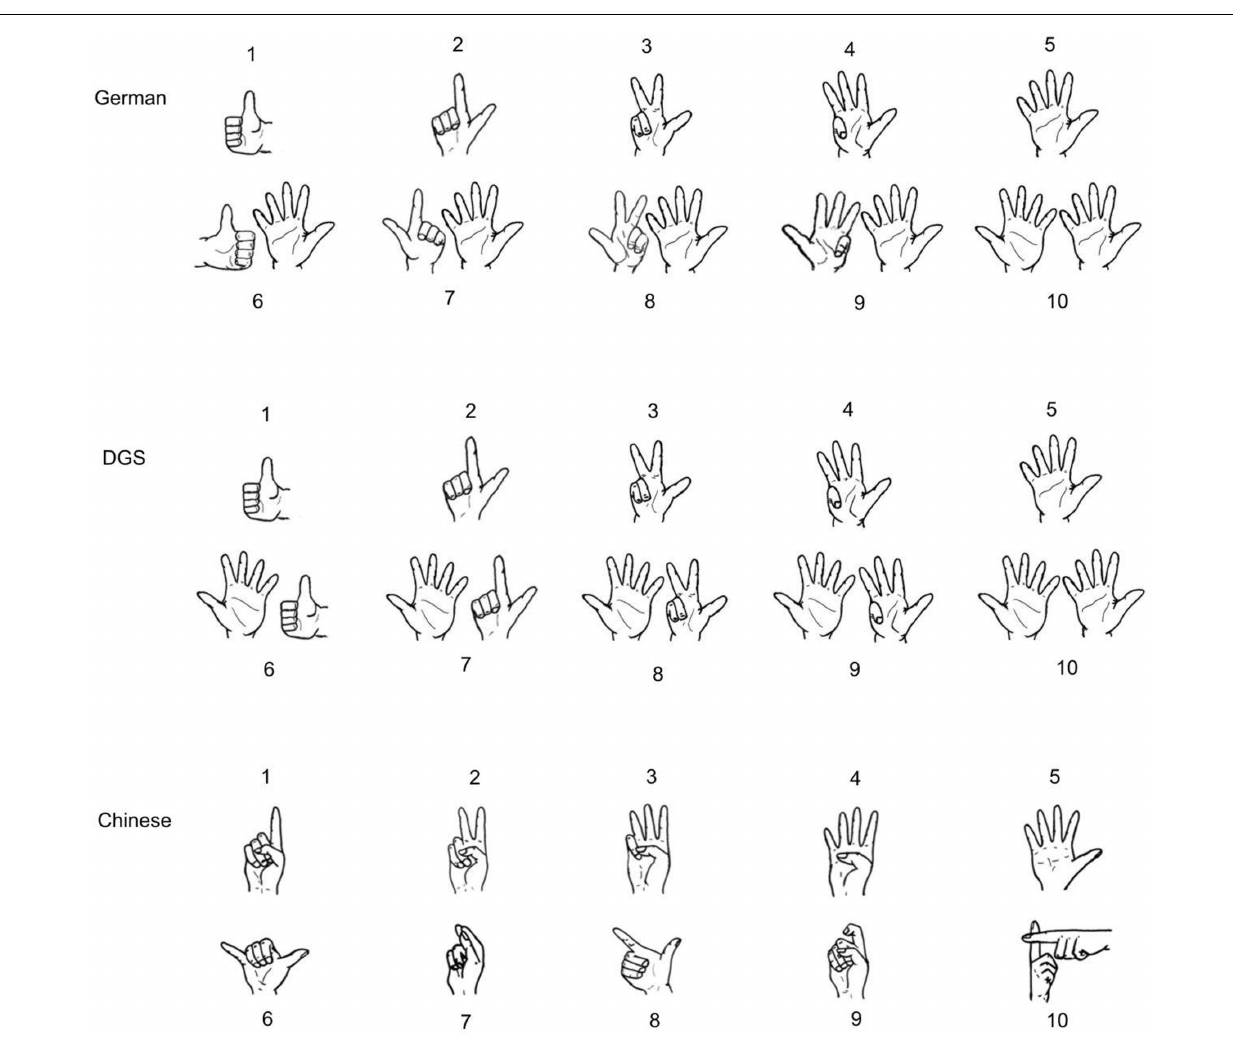
FIGURE 2 | Finger-counting systems in German, German Sign Language (DGS), and Chinese (Domahs et al., 2010). Reprinted with permission.